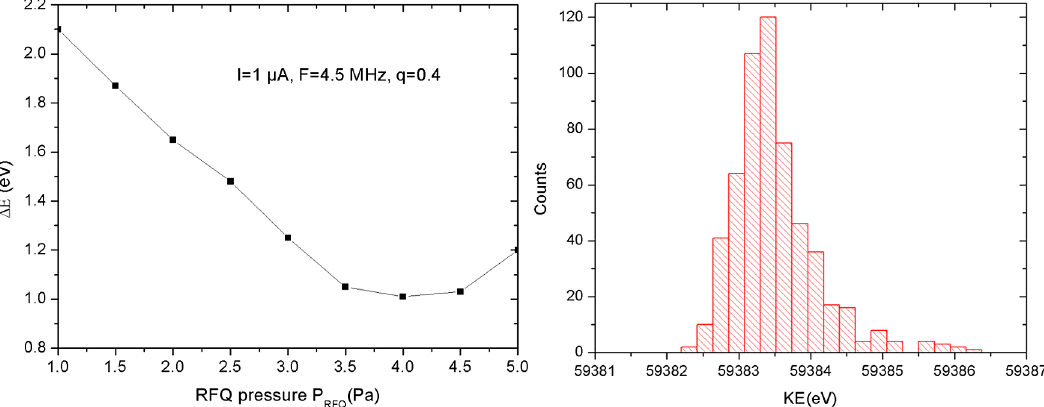
FIG. 8. Effect of RFQ pressure P on the longitudinal energy spread Δ E for 1 μ A of beam current and q ¼ 0 . 4 : variation of Δ E as a RFQ function of P (left), beam energy histogram taken at 4 Pa of P RFQ RFQ